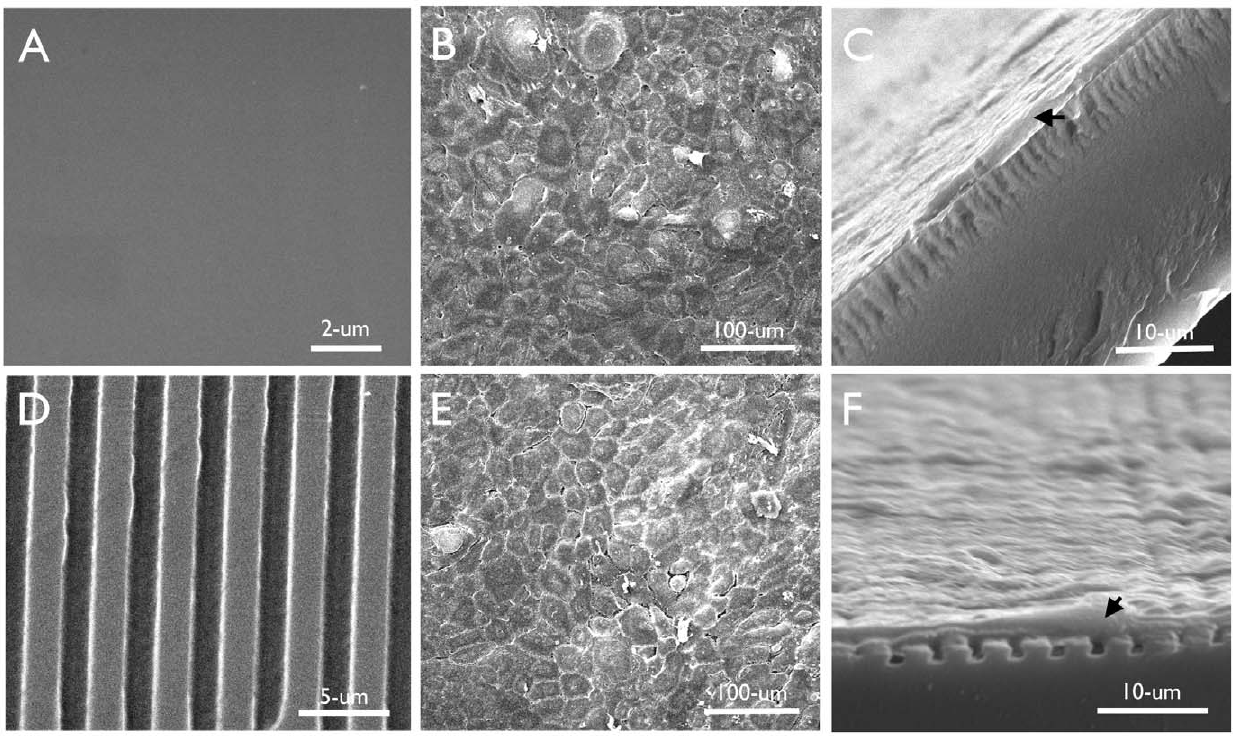
Figure 1. HCLE cells cultured on silk film substrates. (A) Flat silk film surfaces were absent of significant surface roughness, and (B) sustained healthy cell sheet cultures with (C) apparent cellular adherence to the culture surface. (D) Desired lined patterns of 4- m m feature pitch dimensions with 2- m m ridge widths were formed upon the silk film surfaces, and (E) sustained healthy cell sheet cultures with (F) apparent cellular adherence to the top surfaces of the patterned surface topography. substrates [Figure 1F]. Cells adhered to the apical surface of the patterned silk films and did not contact the entire feature depth as desired.